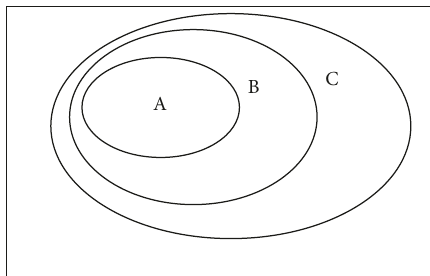
Figure 1: The relationship between macroeconomy, industry, and